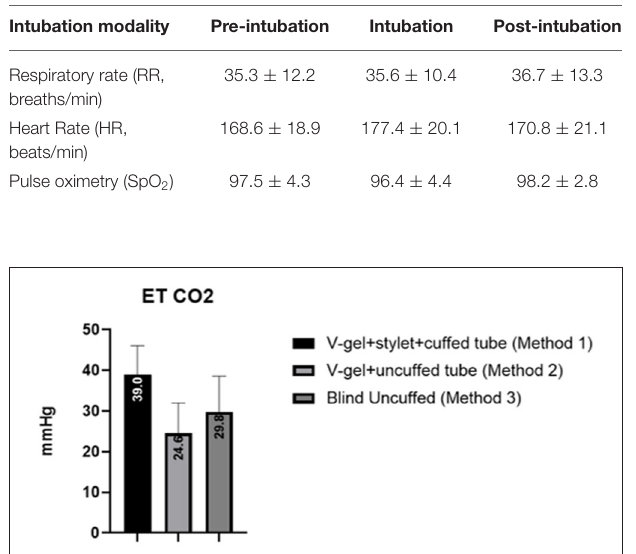
TABLE 2 | Respiratory rate, heart rate, and SpO 2 values recorded pre-, during, and post-intubation.